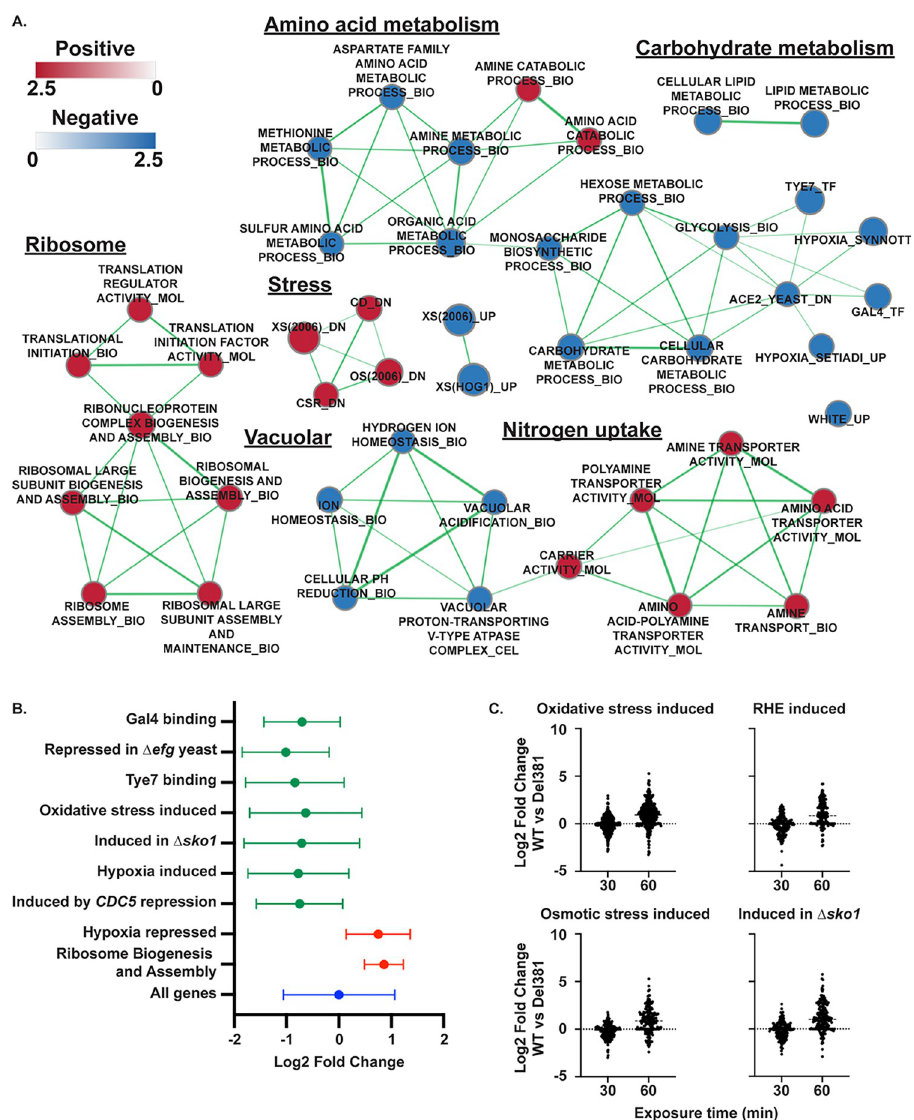
Fig 11. Cells containing derepressed TOR1-Del381 upregulated ribosome biogenesis and translation related genes but decreased expression of carbon metabolism- and stress response genes. A. Enrichment map showing the major categories of genes identified by Gene Set Enrichment Analysis (GSEA) in the transcript profile of tor1/ tetO-TOR1-Del381 cells (JKC1441) grown in YPD without doxycycline compared to the heterozygote tor1/TOR1 (JKC1347). Nodes represent gene sets (FDR q < 0.1) where color intensity reflects the Normalized Enrichment Score (NES) and node size reflects the number of enriched genes. Width of connecting lines (edges) indicates the degree of overlap between categories. B. Gene set enrichment analysis was used to identify major categories of genes significantly regulated (adjusted P value < 0.001) in tor1/tetO-TOR1-Del381 cells (JKC1441) compared to the tor1/TOR1 control (JKC1347). Graph shows the fold change (Log2) of genes in each indicated category in Del381 cells relative to tor1/ TOR1 cells. Full results in S1 File and S2 File. C. Specific gene categories were altered in cells lacking N-terminal HEAT repeats during superoxide stress. Comparison of gene expression in wild type (WT, SC5314) relative to tor1/ tetO-TOR1-Del381 (JKC1441) in the presence of plumbagin (10 μ M) after 30 and 60 minutes. Gene categories shown were significantly represented (Q < 0.001) among genes exhibiting increased expression in the wild type relative to tor1/tetO-TOR1-Del381 cells following 60 minutes incubation in plumbagin. Gene categories are those identified by Enjalbert et al. (oxidative and osmotic stress;[67]), Rauceo et al. ( Δ sko1 ; [112]) and Spiering et al. (Reconstituted human epithelium induced;